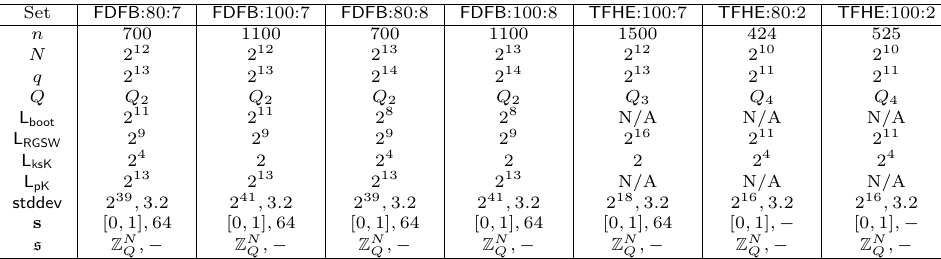
Table 2: Parameter Sets. The modulus Q 1 = 2 62 − 65535, Q 2 = 2 63 − 278527, Q 3 = 2 48 − 163839, and Q 4 = 2 32 − 139263. For all parameters sets we set the error variance of fresh (R)LWE samples to 10 . 24 which corresponds to standard deviation 3 . 2. The key s is always binary; thus u =